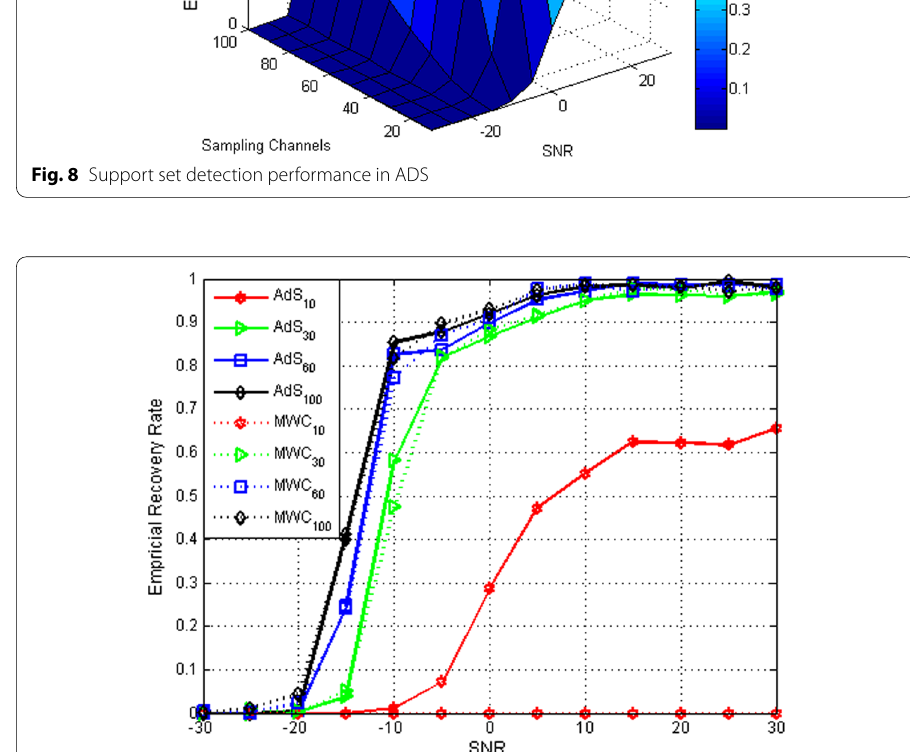
Fig. 9 Percentage of correct support recovery, when m =